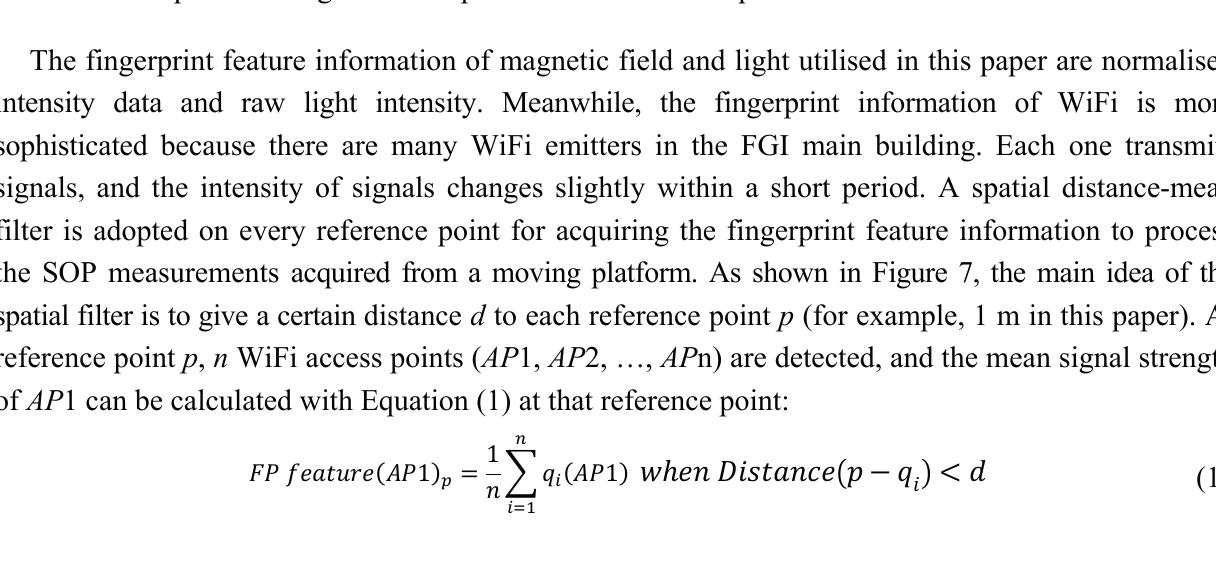
Figure 6. ( a ) Data process workflow of fingerprint map creation; ( b ) an example of a result from the position-magnetic field pairs list from the data